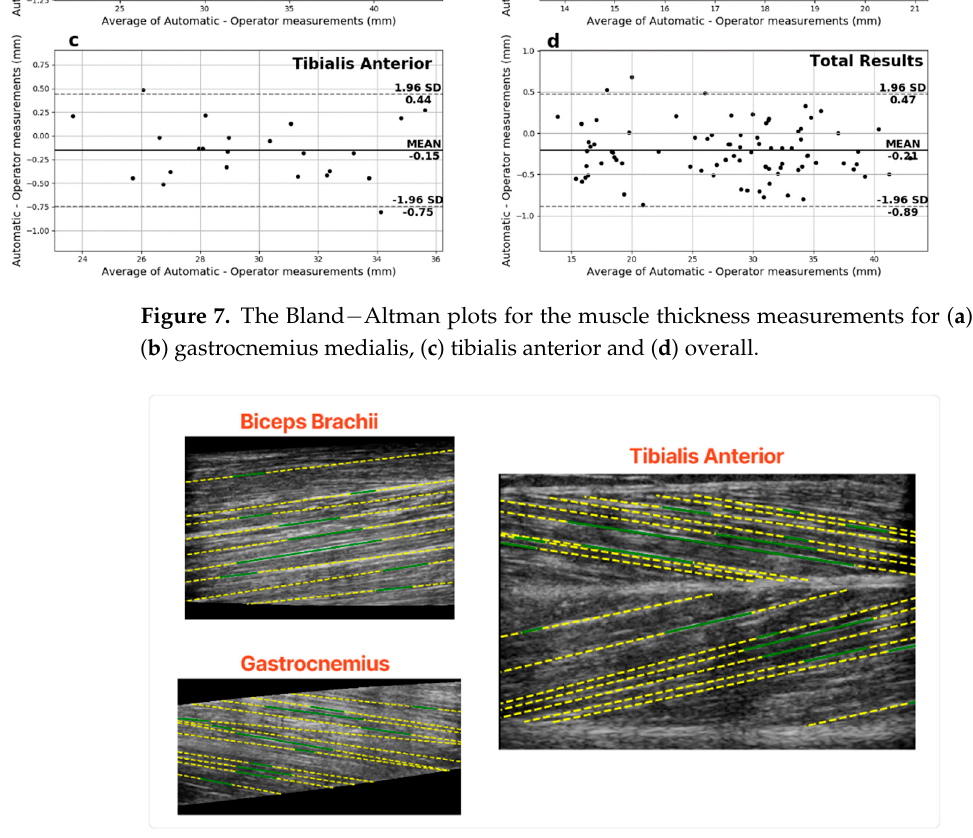
Table 3. Comparative RMSE results of the pennation angle and fascicle length measurements. The fascicle length is measured in mm and the pennation angle in degrees.